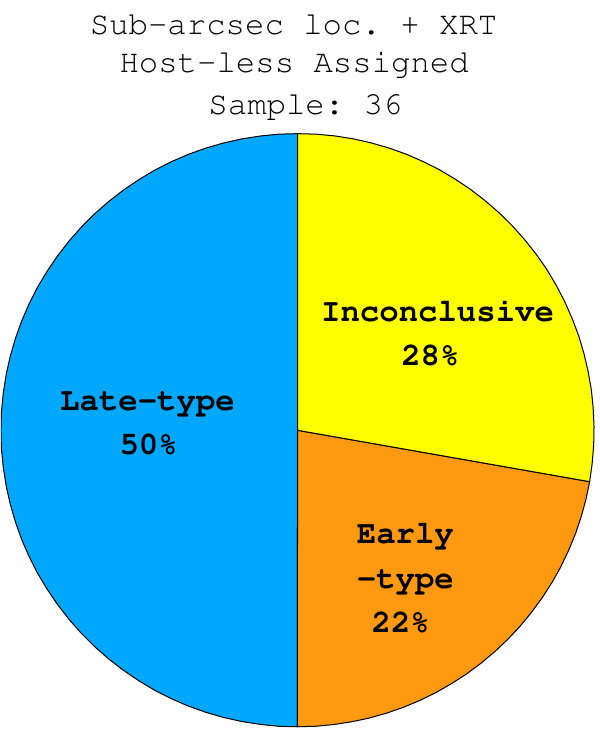
Figure 1. Pie diagram that shows the types of SGRB host galaxies. Source: Figure 13a in